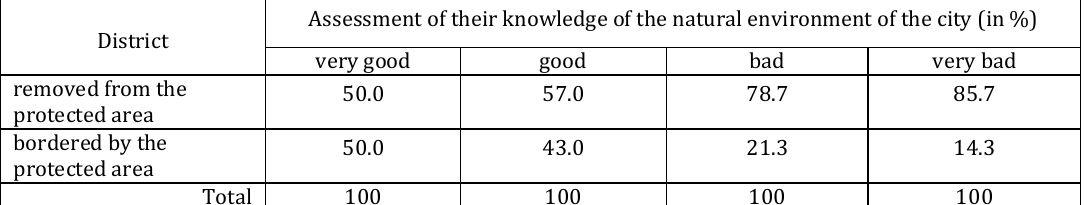
Table 3. Self-reported knowledge about the natural environment of Bielsko-Biała, by their area of residence Assessment of their knowledge of the natural environment of the city (in %) District